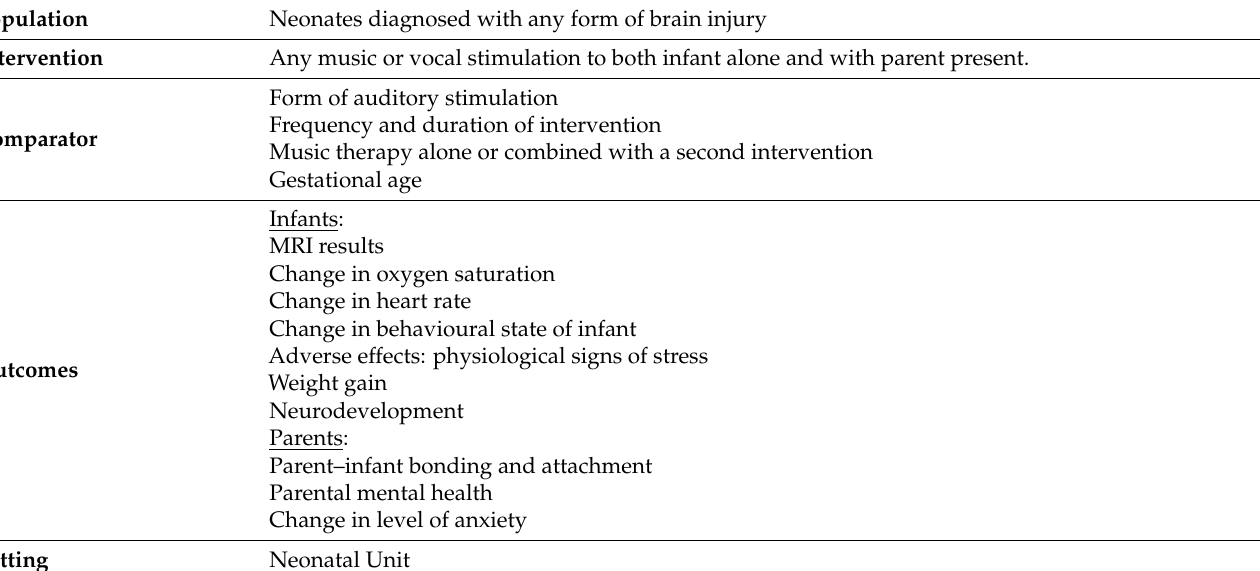
Table 2. Inclusion